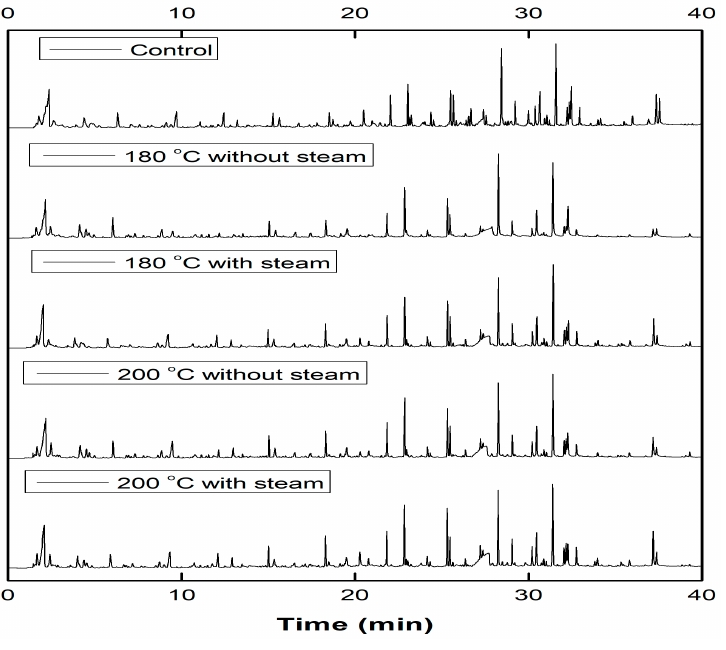
Figure 5. Pyrolysis chromatograms of the control and densified samples.